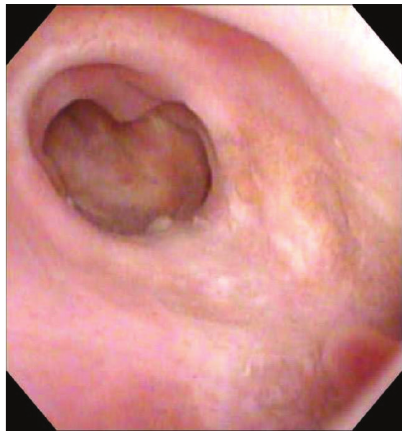
Figure 5: Urethroscopy at 8-month